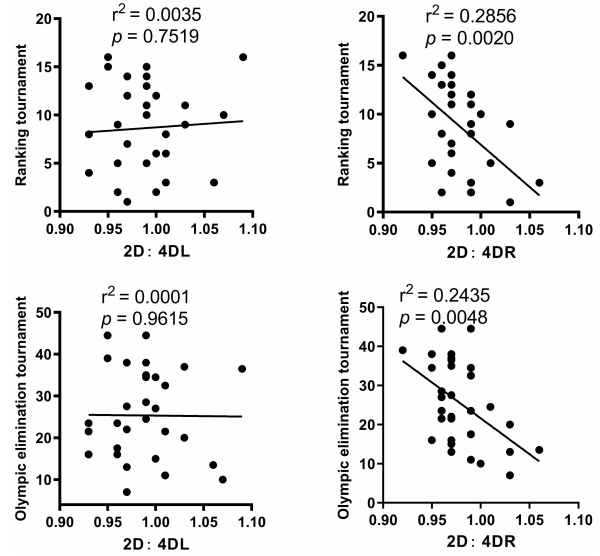
Fig. 3. The correlation between 2D:4D and sporting perfor-